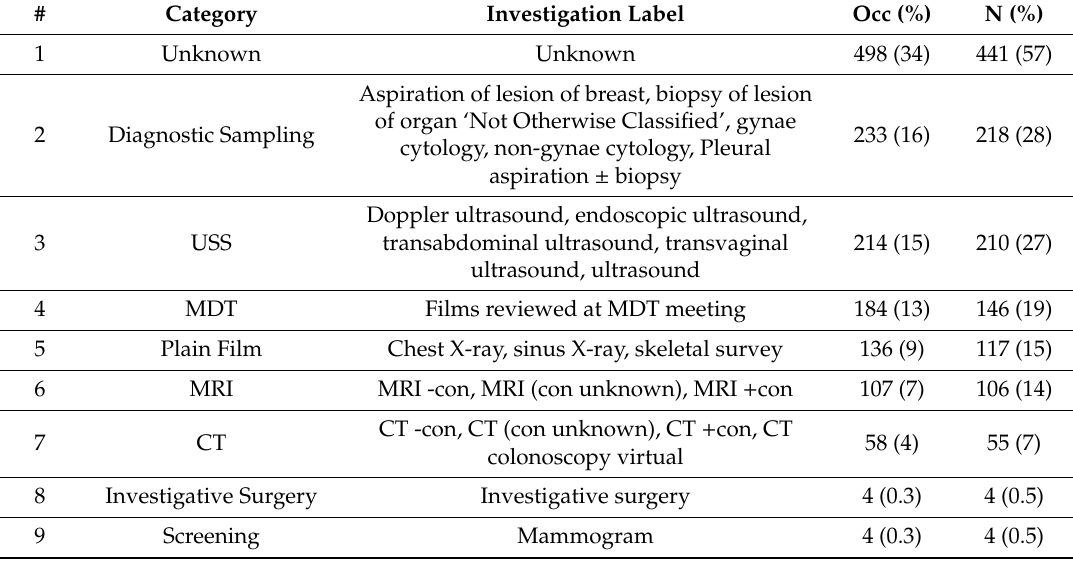
Table 5. Summary of investigation categories. Occ (%) shows the number of occurrences and the percentage of the total occurrences in the event log. N (%) shows the number and percentage of patients undergoing a specific investigation category.